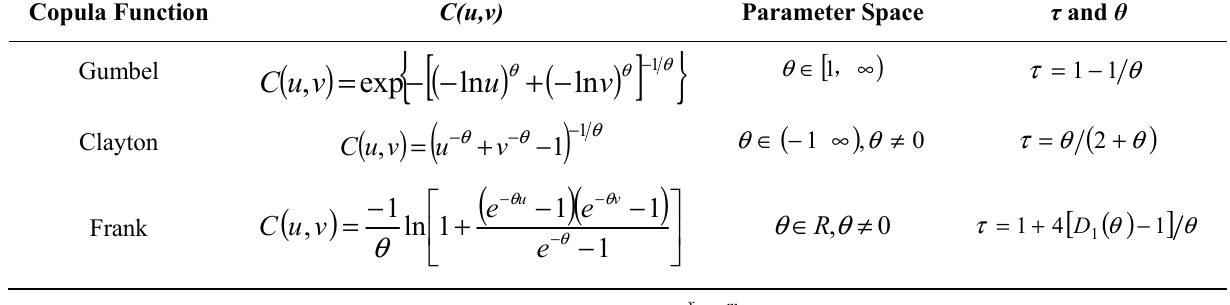
Table 2. Common types of Copula function and parameter estimation formula. Copula Function C(u,v) Parameter Space τ and θ